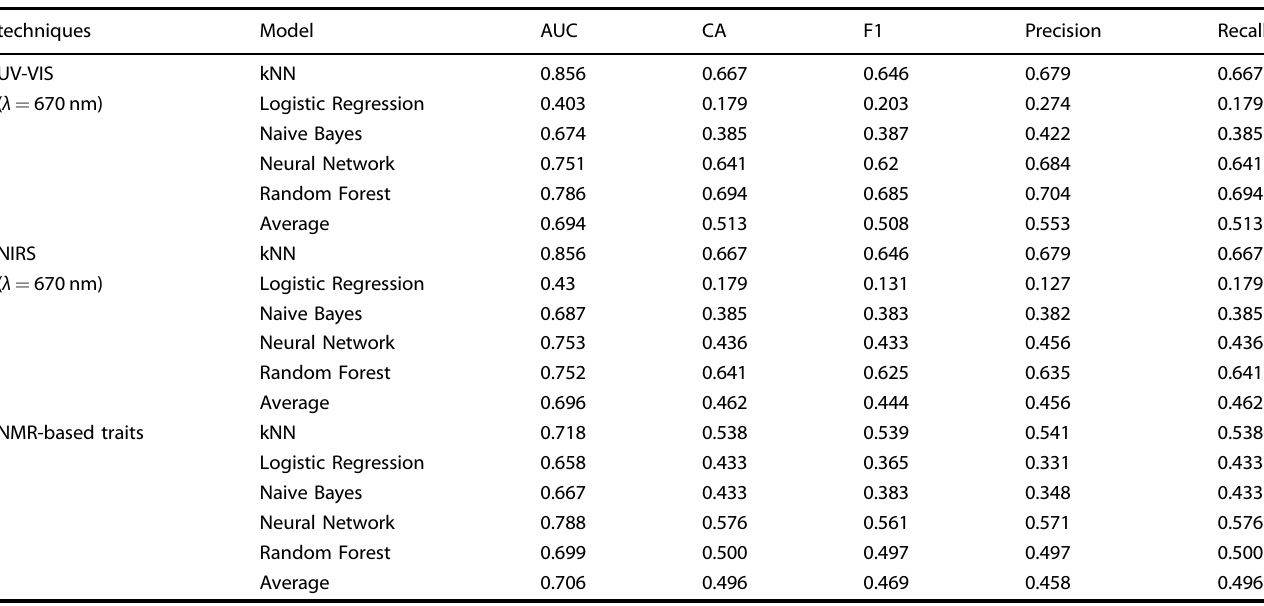
Table 2. Receiver Operating Characteristic analysis for regions of